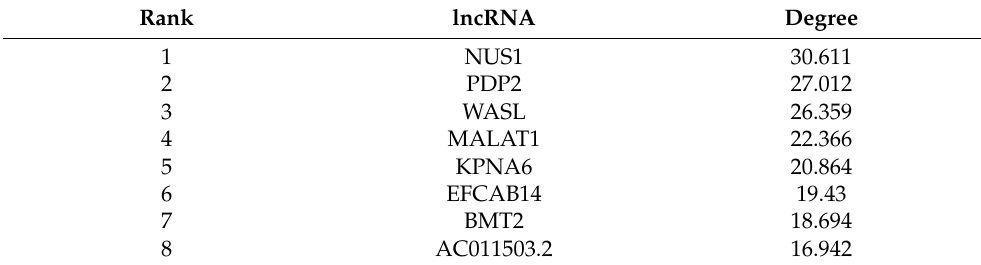
Table 4. lncRNAs in the key subnetworks sorted according to the node scores (from highest to lowest). Rank